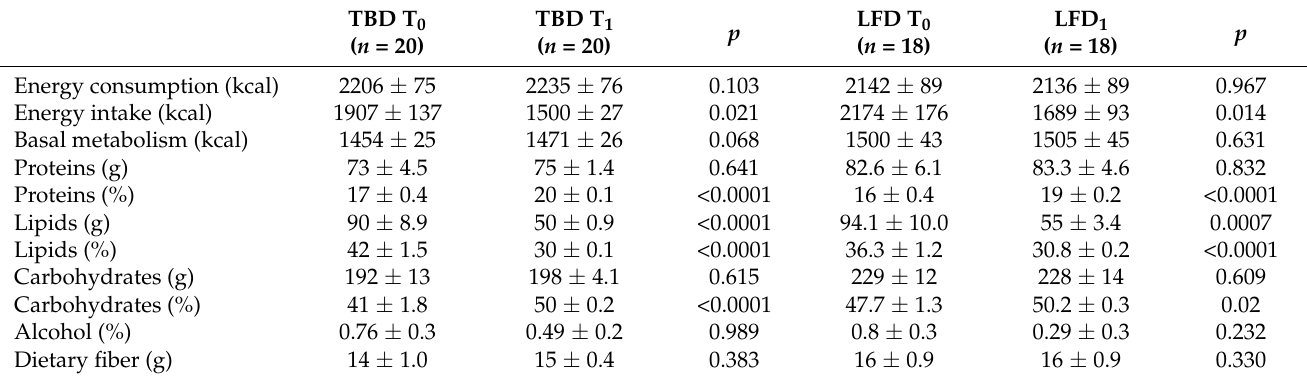
Table 2. Daily nutritional information of the IBS-D patients before (T 0 ) and after (T 1 ) 12 weeks of tritordeum-based diet (TBD) and low-FODMAP diet (LFD).